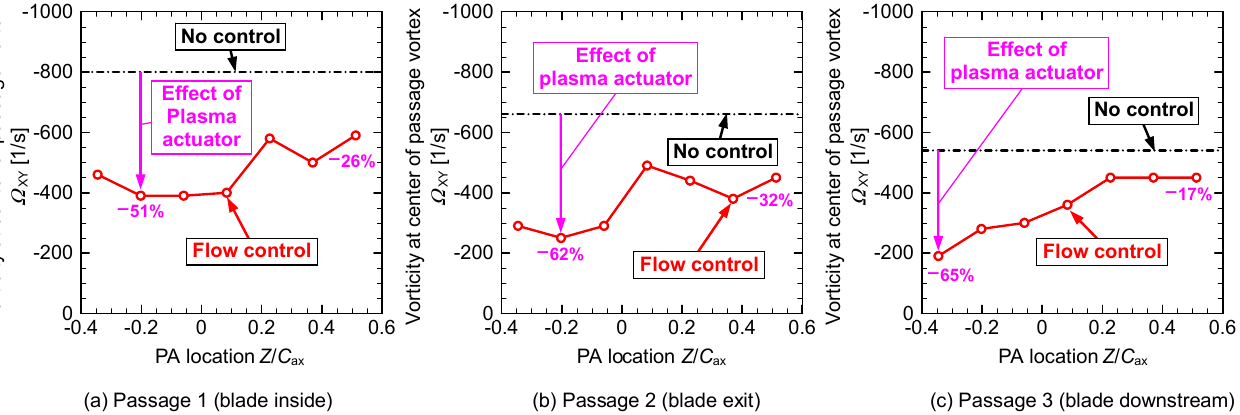
Figure 16. Effect of the plasma actuator location on the peak vorticity of the passage vortex (Re out = 1.8 × 10 4 ).